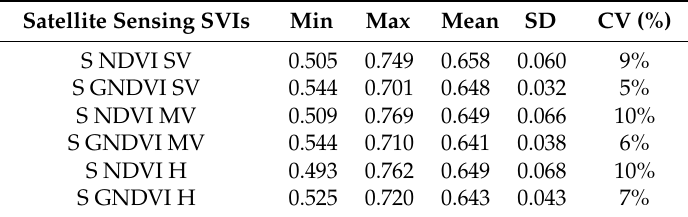
Table 4. Descriptive statistics of the satellite based spectral vegetation indices (SVI) at different crop stages for the three years.